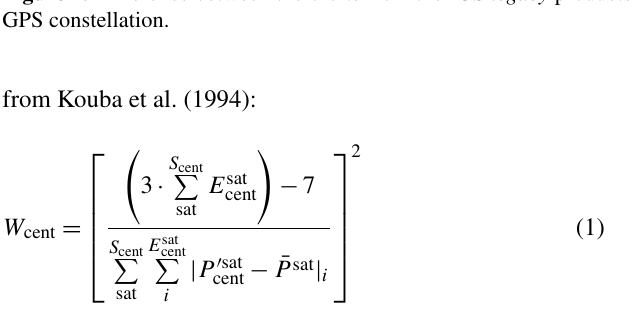
Figure 1. Difference between the orbits from the IGS legacy products and the MGEX products, submitted by two ACs (CODE and GFZ) – GPS